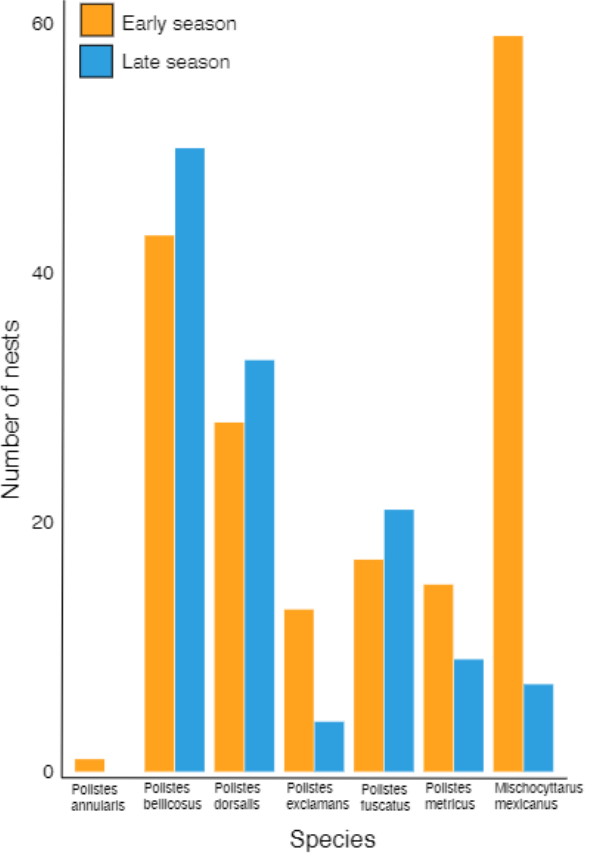
Figure 1. Number of nests from seven polistine species observed in early and late season during 2016.